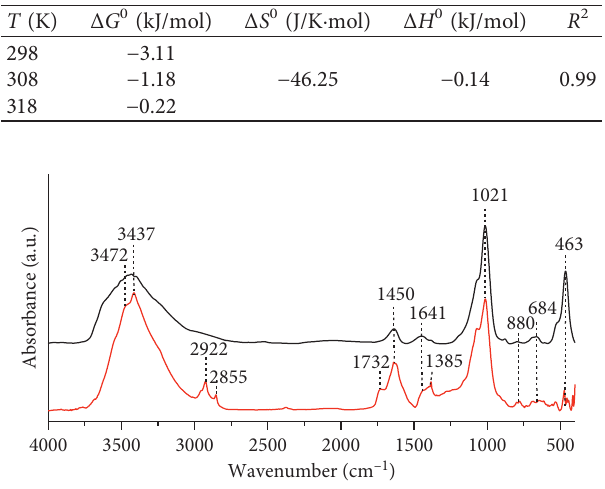
Table 6: Thermodynamic parameters of adsorption of polyphenols onto Gh-B.